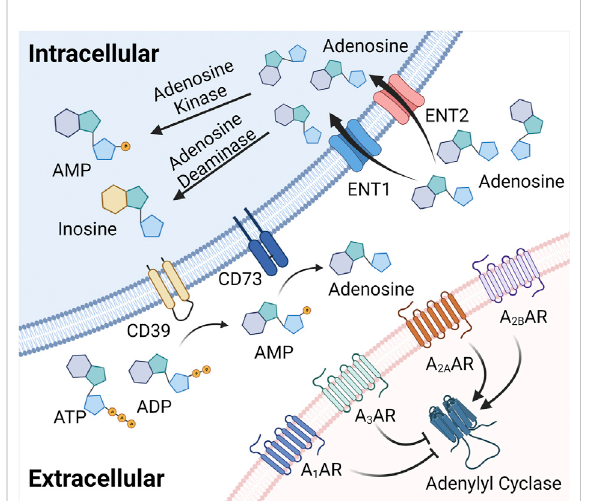
FIGURE 2 Links between hypoxia and extracellular adenosine. Several studies have elucidated the molecular mechanisms involved in hypoxia-dependent enhancement of extracellular adenosine signaling.Firstly,hypoxia andconcomitantHIF1Astabilization directlyinducestheexpressionallevelsofCD73.Secondly,hypoxia dependent CD39 induction is controlled by a transcriptional mechanism involving SP1 Furthermore, HIF1A and HIF2A stabilization results in the enhancement of adenosine receptors expression, such as Adora2b and Adora2a, respectively. Finally, previous studies also implicate HIF1A in the repression of both ENTs and adenosine kinases, which indirectly promotes the additional elevations of extracellular signaling